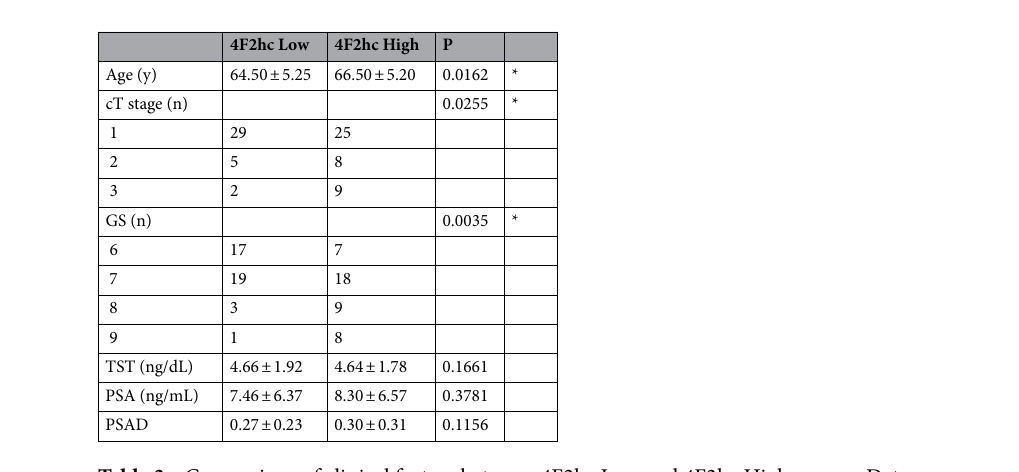
Table 3. Comparison of clinical factors between 4F2hc Low and 4F2hc High groups. Data are expressed as means ± standard deviation unless otherwise indicated. cT stage = clinical tumour stage, GS = Gleason score, TST = testosterone, PSA = prostate-specific antigen, PSAD = PSA density. *Statistical significance ( p < 0.05).